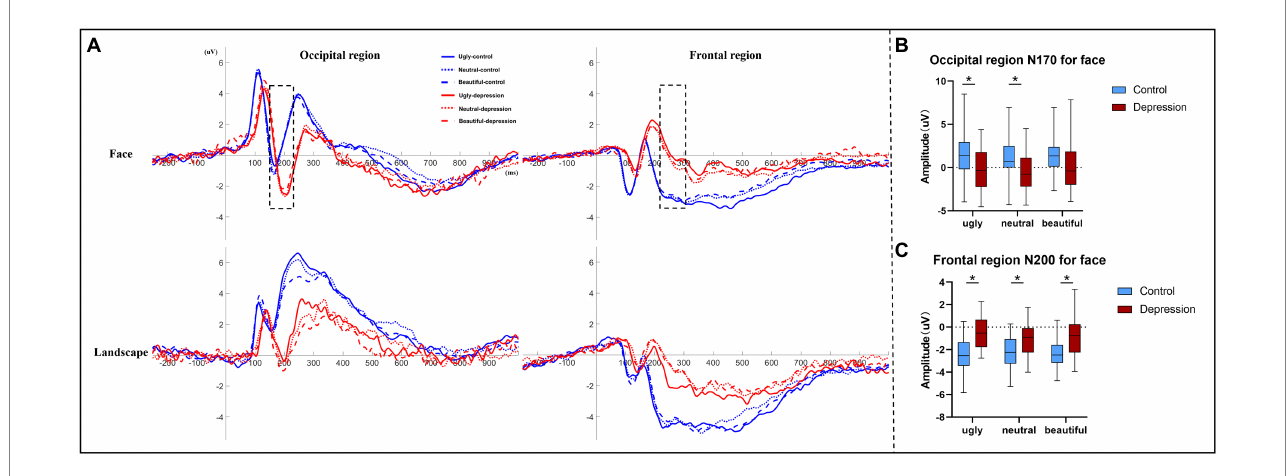
FIGURE 3 (A) Event-related potentials (ERP) averaged over the occipital region and the frontal region, respectively, are shown as a function of stimuli type, valence, and group. Only the two ERP components (occipital N170 and frontal N200) marked by dotted lines showed a significant interaction between group and valence. (B) The amplitudes of face-evoked occipital N170 are shown as a function of valence and group, and (C) the amplitudes of frontal N200 evoked by faces are shown as a function of valence and group. The error bars indicate the range of the amplitude values. The upper and lower boundaries of the colored square indicate the upper and lower quartiles of the amplitudes, and the black horizontal lines indicate the median of the amplitudes. * indicates a significant